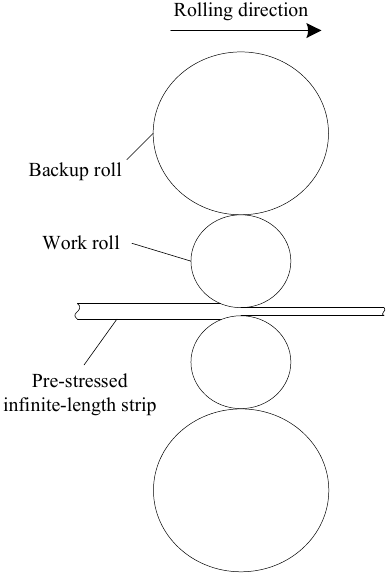
Figure 1. Schematic illustration of the rolling process of a pre-stressed infinite-length strip.